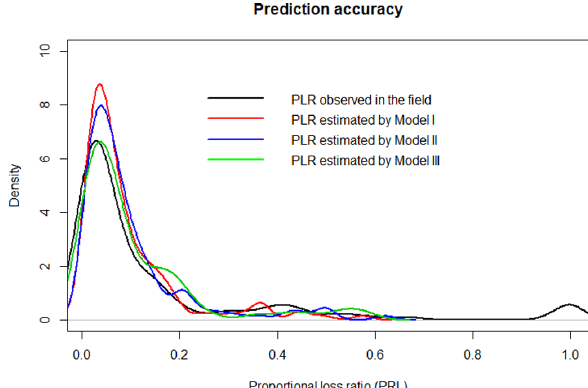
Fig. 4. Kernel density plot (Gaussian kernel, bandwidth: 1) of ob- served versus predicted proportional losses for the 132 damaged